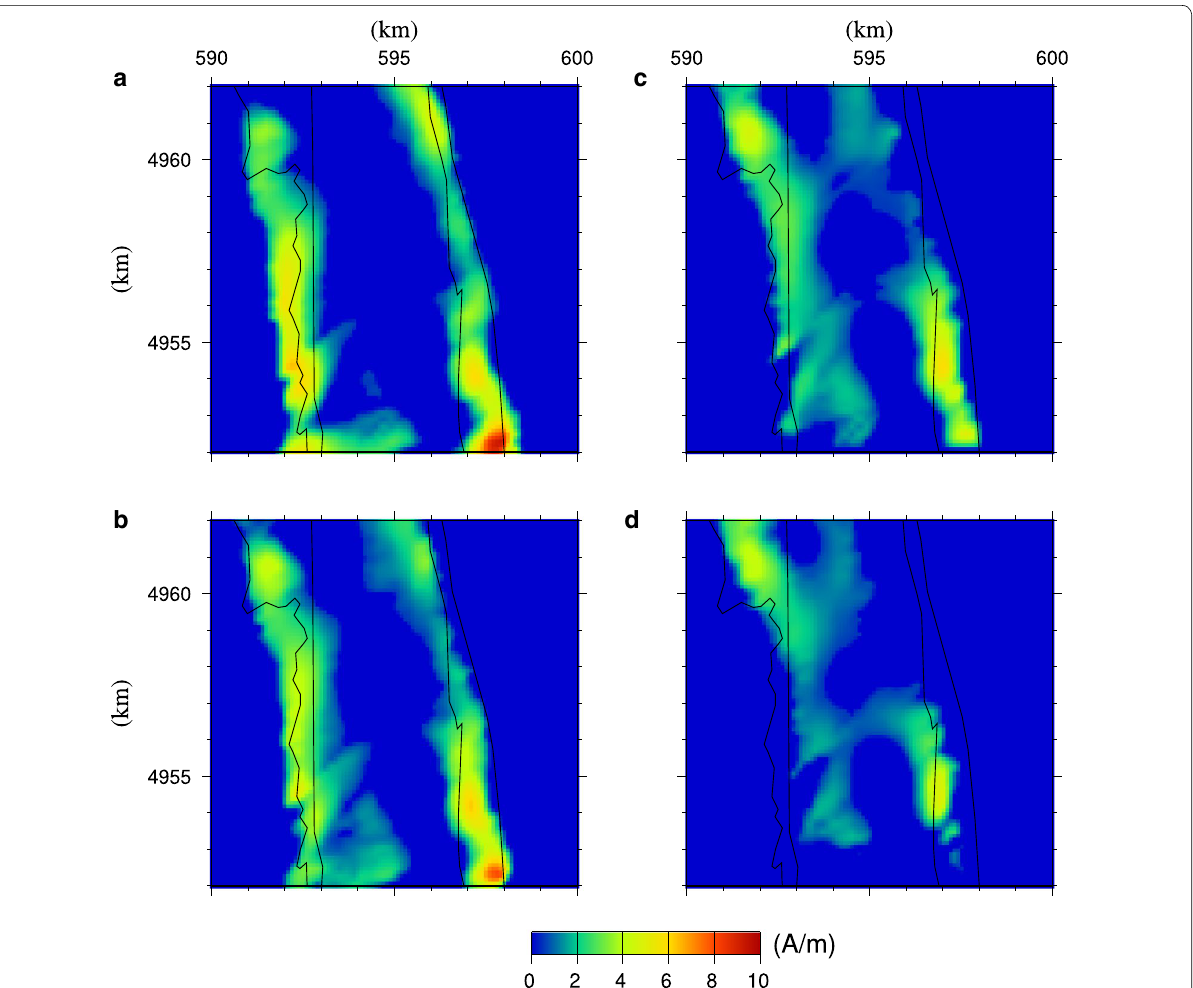
Fig. 23 The slice of the optimal magnetic model. The slice of the optimal magnetic model at the depth of a 200 m, b 400 m, c 600 m, and d 800 m, respectively. On each figure, the location of the exposed serpentine belts is displayed in solid lines. The coordinate system of this figure is UTM, and the color scale indicates the induced magnetization in